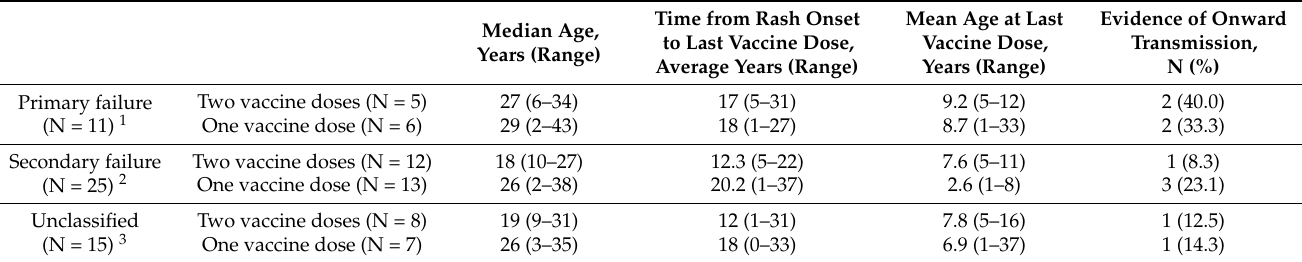
Table 2. Characteristics of individuals with primary and secondary MV vaccine failure.